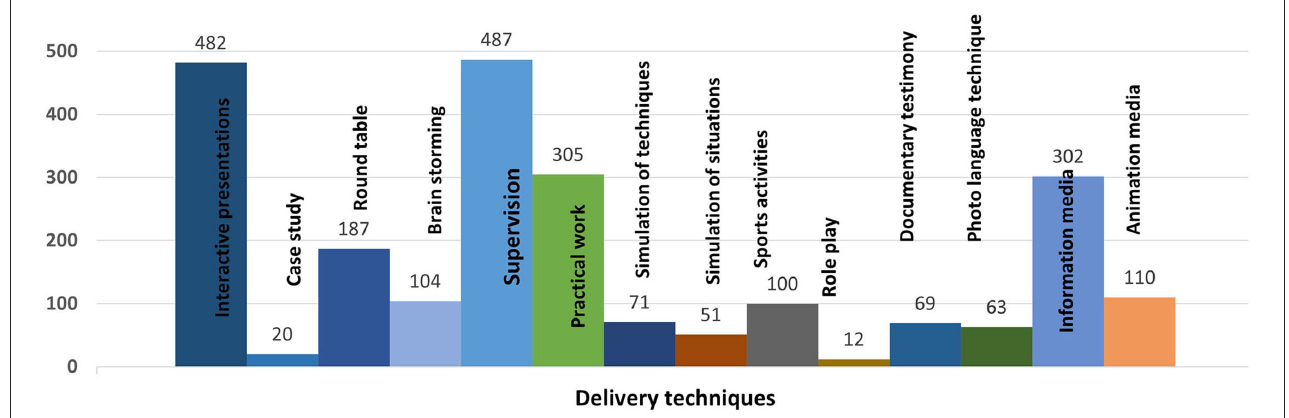
FIGURE3 Proportion of studies employing specific techniques for delivery of therapeutic patient education interventions.